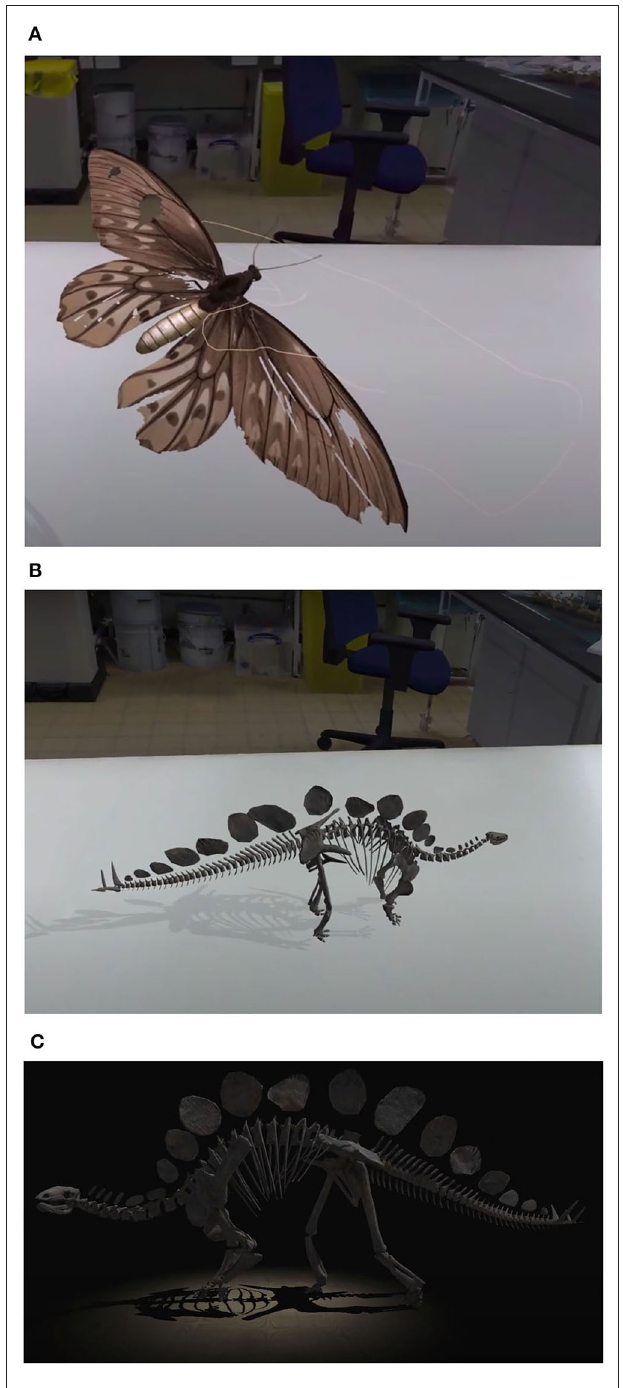
FIGURE 1 | (A) Butterfly with outline hand grasp; (B) Stegosaurus; (C) Dinosaur when animated.